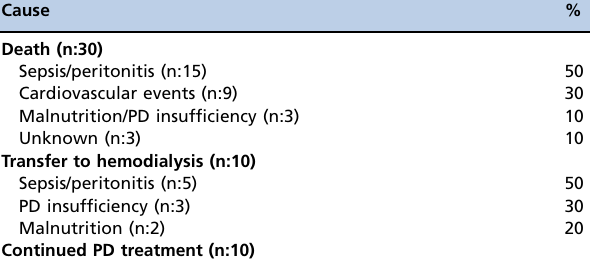
Table 3 - Final status of the